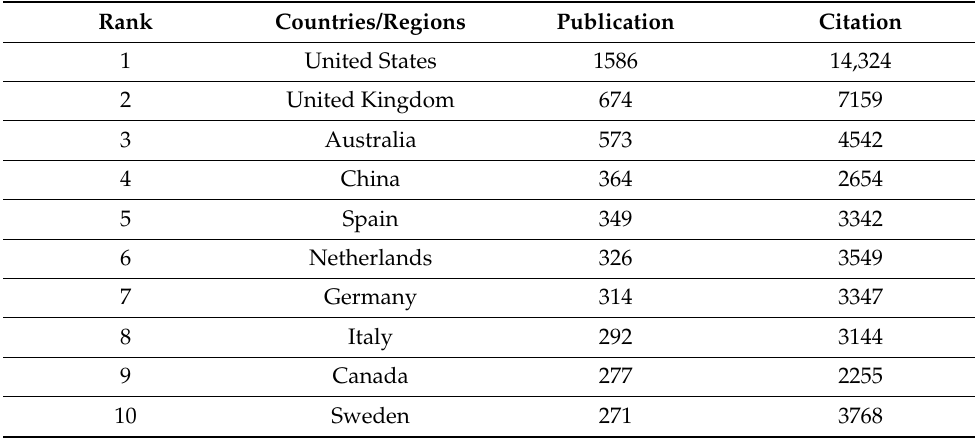
Table 3. Top five organizations publishing lifestyle research, 2016–2020.